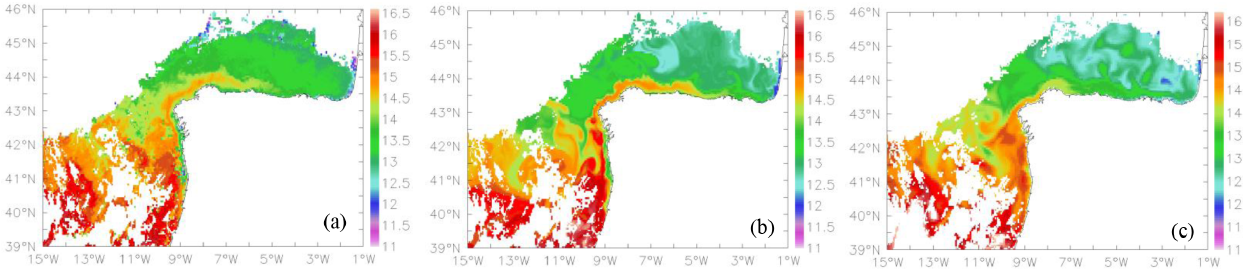
Fig. 15. Navidad: surface warm current along Spanish and French coasts. (a) AVHRR SST; (b) V2 system (IBI-V2-CONT) SST; (c) V1 system.